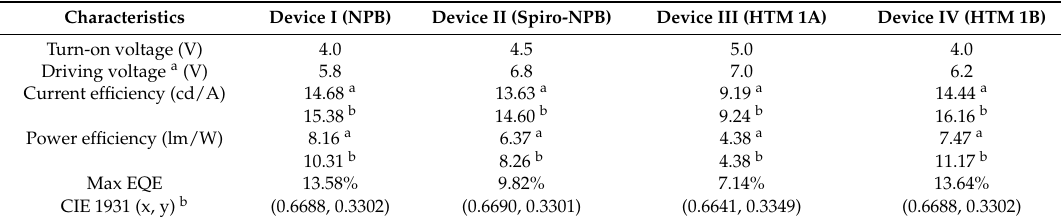
Table 2. Device characteristics.